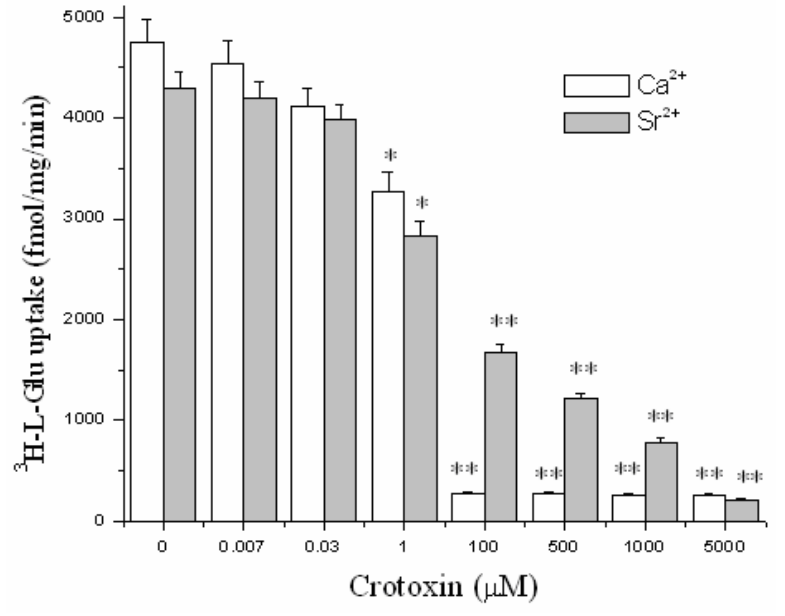
Figure 5. 3 H-L-glutamate uptake by RCCS. 2 mM of Ca 2+ or 7.6 mM of Sr 2+ and 1 mM of EGTA were added. Different crotoxin concentrations were incubated at room temperature with RCCS for 20 min followed by the uptake assay. Asterisks indicate significant uptake inhibition (** p<0.01 ; * p<0.05